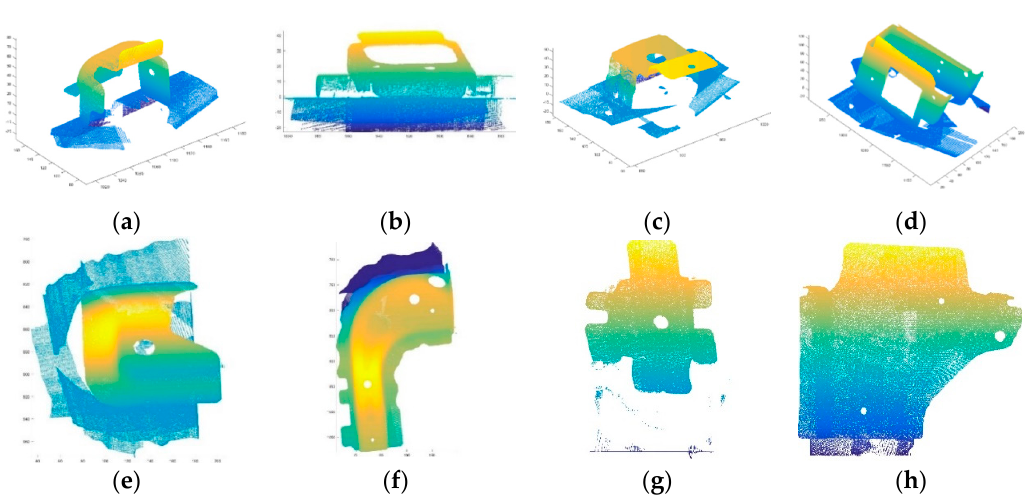
Figure 3. The experimental data. ( a )–( h ) are a series of measurement data of vehicle body parts, respectively.